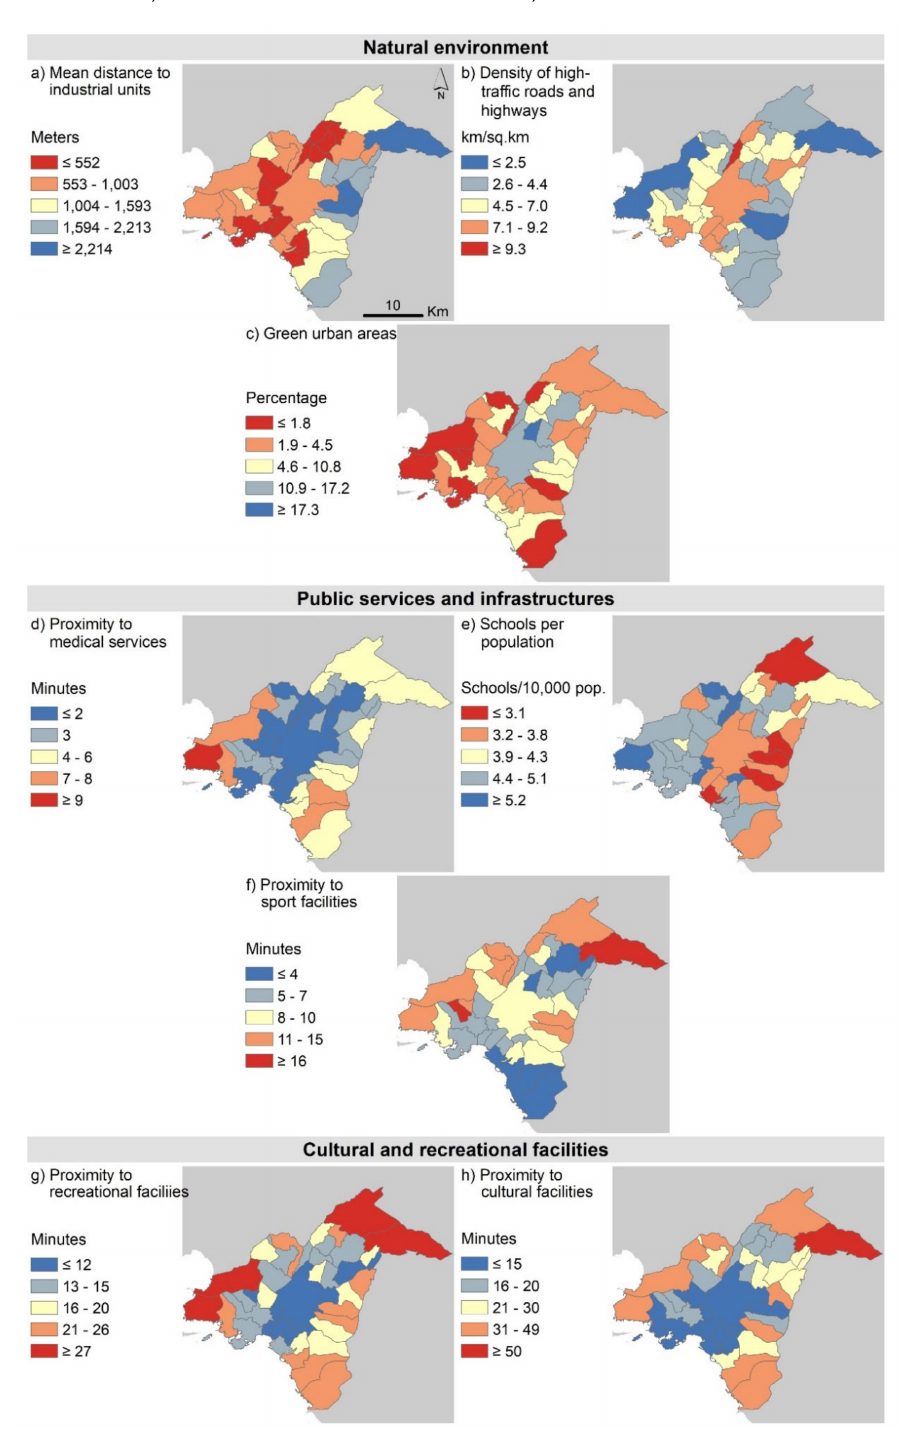
Figure 4. Indicators for the Natural environment, Public services and infrastructures, and Cultural and recreational facilities, across municipalities of AMA, Greece. ( a ) Mean distance to industrial units, ( b ) density of high-traffic roads and highways, ( c ) percentage of green urban areas, ( d ) proximity to medical services, ( e ) schools per 10,000 population, ( f ) proximity to sport facilities, ( g ) proximity recreational facilities, ( h ) proximity to cultural facilities. (Red color in each map indicates low QoL and blue color high QoL